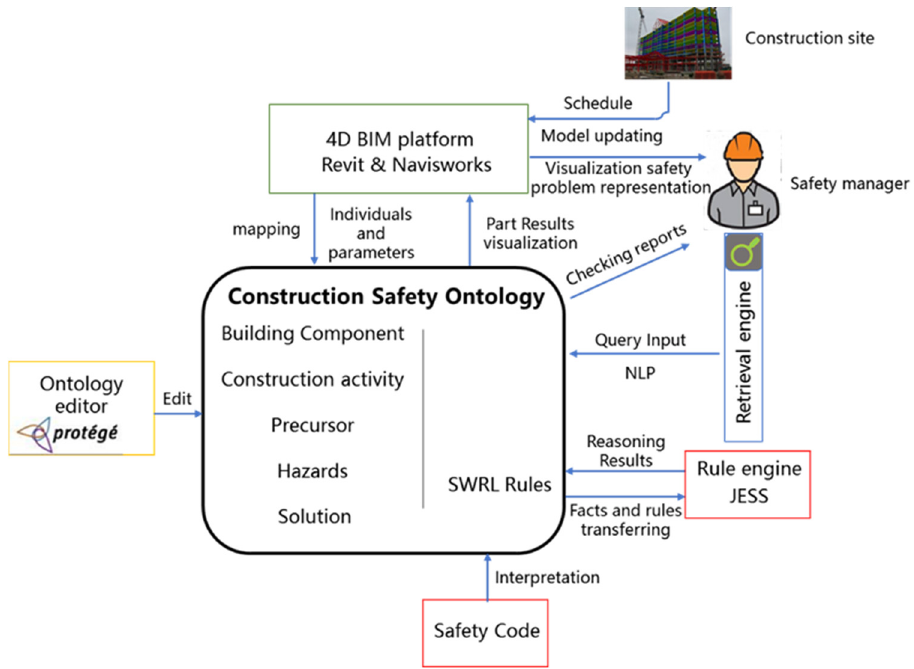
Figure 1. Illustration of the framework.